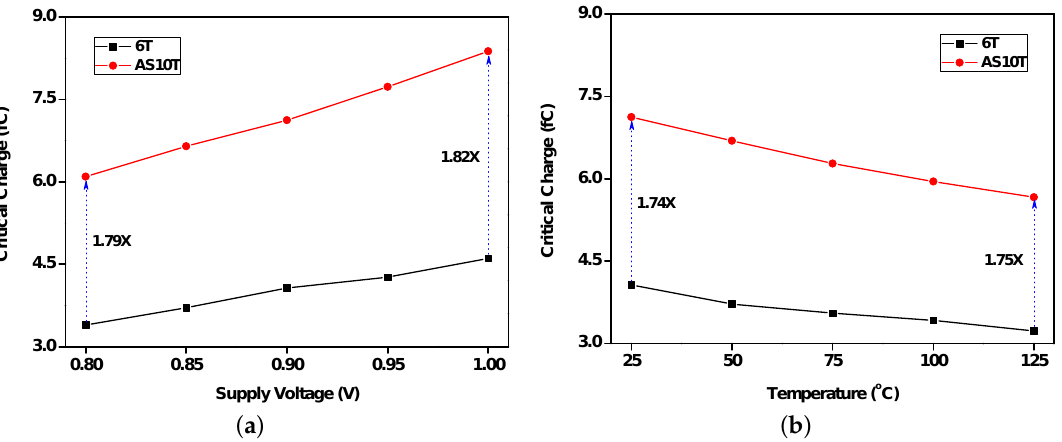
Figure 9. Critical charge at the sensitive node of SRAM cells ( a ) with supply voltage variation ( b ) with temperature